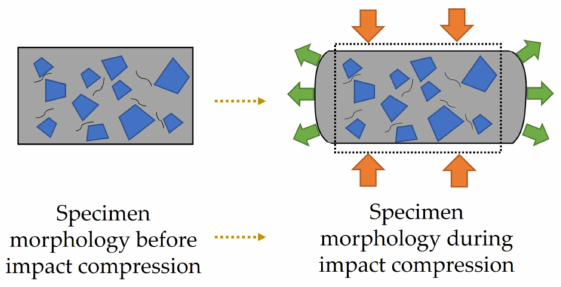
Figure 11. Specimen changes during impact